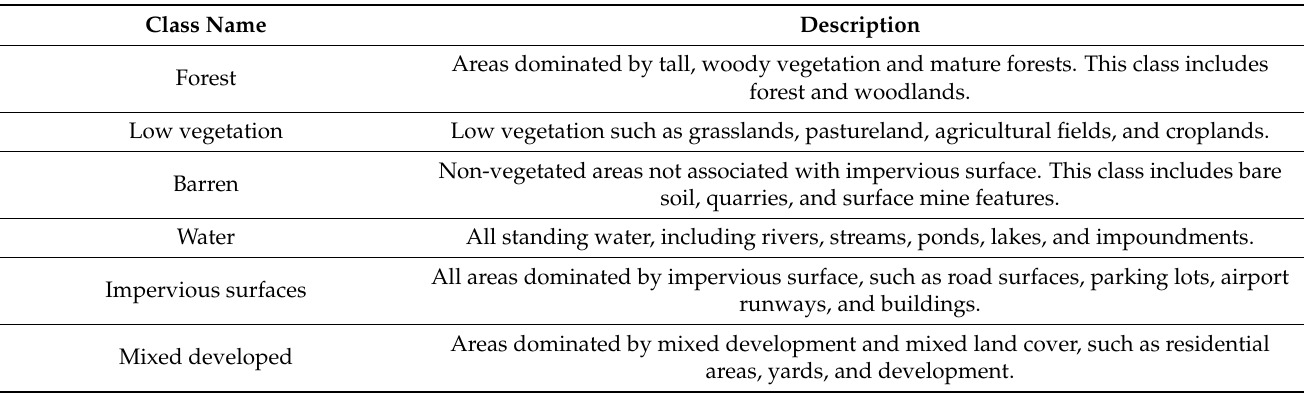
Figure 5. Category size errors for 1996. Miss and false alarm as number of observations. Table 5. The 2016 land cover classes definition.